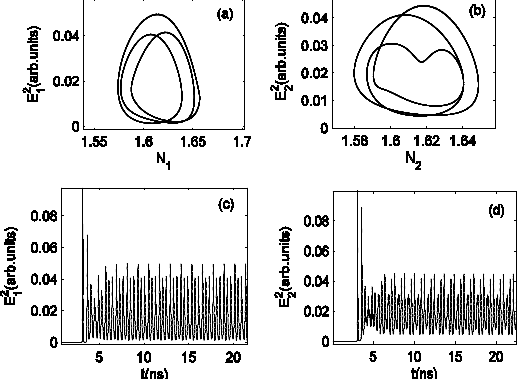
Fig. 4. Different quasi-cycle orbits of two lasers and output. (a) a cycle-three orbit of laser 1. (b) a cycle-four orbit of laser 2.(c) laser 1 output. (c) laser 2 output.